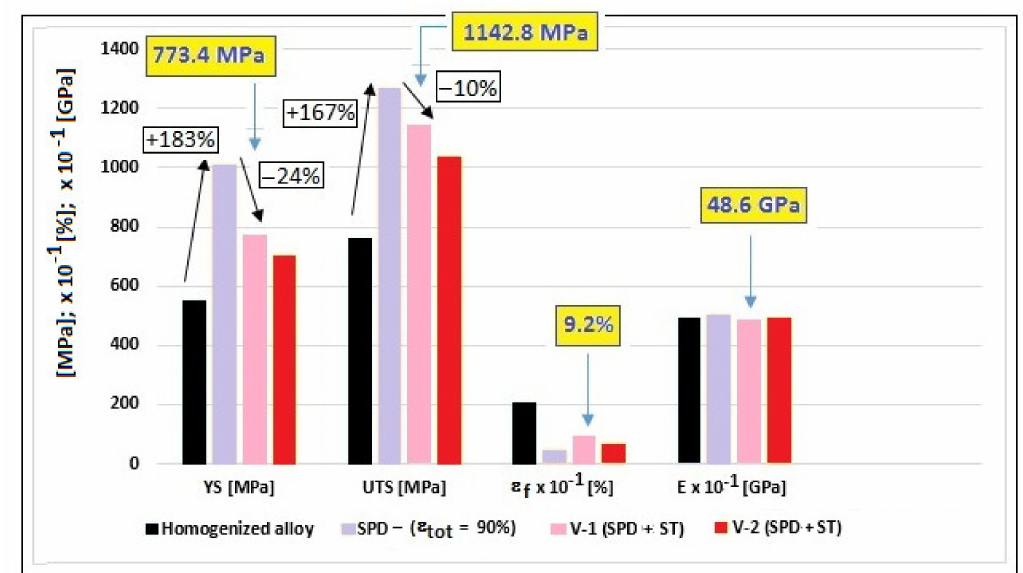
Figure 9. Mechanical properties of the studied alloy for all experimented states; in yellow squares—the promising combination of mechanical properties corresponding to the V-1 processing